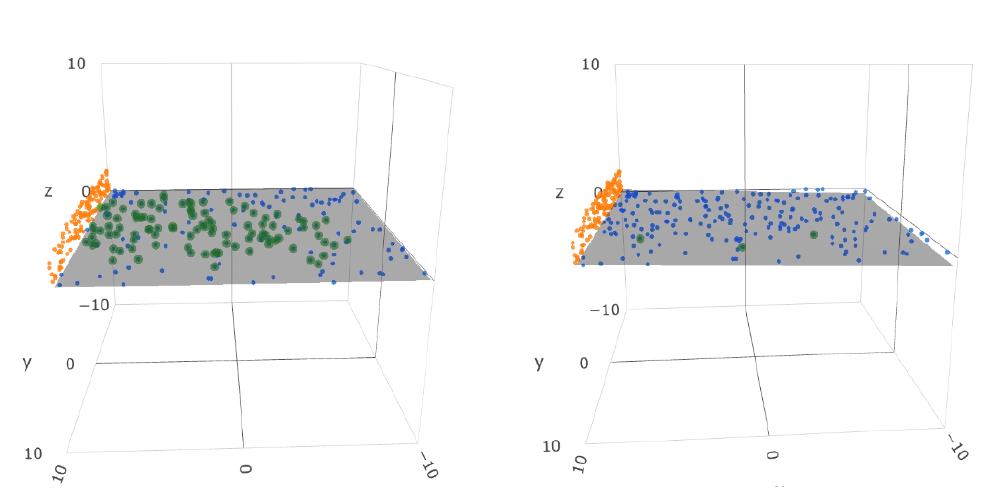
Figure 1. Example of the vicinity of the edge points. A set of core points (green dots) and an estimated plane (dark grey plane) determined with the MCS or the FAST-MCD